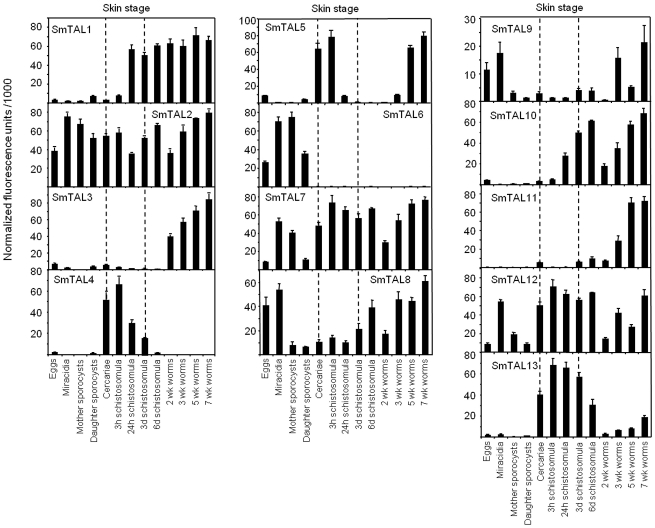
Transcription profiles of SmTALs.Profiles from the S. mansoni lifecycle microarray data available via Array express (31) under the experimental accession number E-MEXP-2094. Values are mean normalized fluorescence units ± sem. In primate infections, larvae remain in the skin for 2–5 days (Wilson et al. 1990). In the figure cercariae to 3 d schistosomula are denoted “skin stage”.